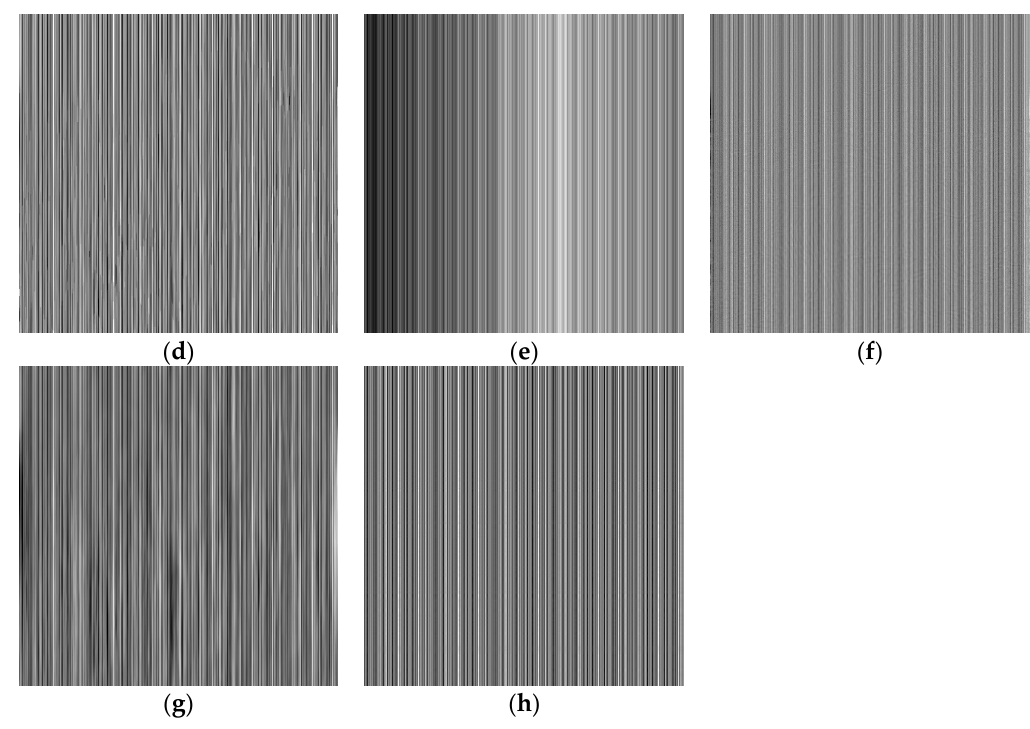
Figure 13. Stripes extracted by various methods. ( a ) Added CFPN; ( b ) WAFT; ( c ) UTV; ( d ) ASSTV; ( e ) VSNR; ( f ) SILR; ( g ) ℓ (cid:2868) sparse; ( h ) LRSUTV.